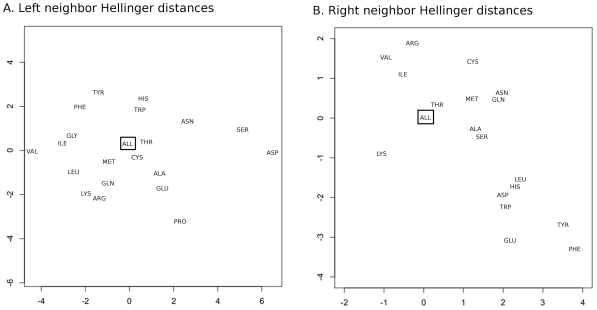
Multi-dimensional scaling plots of average Hellinger distances.
A: left neighbors. B: right neighbors. The distance between any two neighboring residue in the plots is approximate. “ALL” indicates all residues as neighbor and is boxed in each figure.